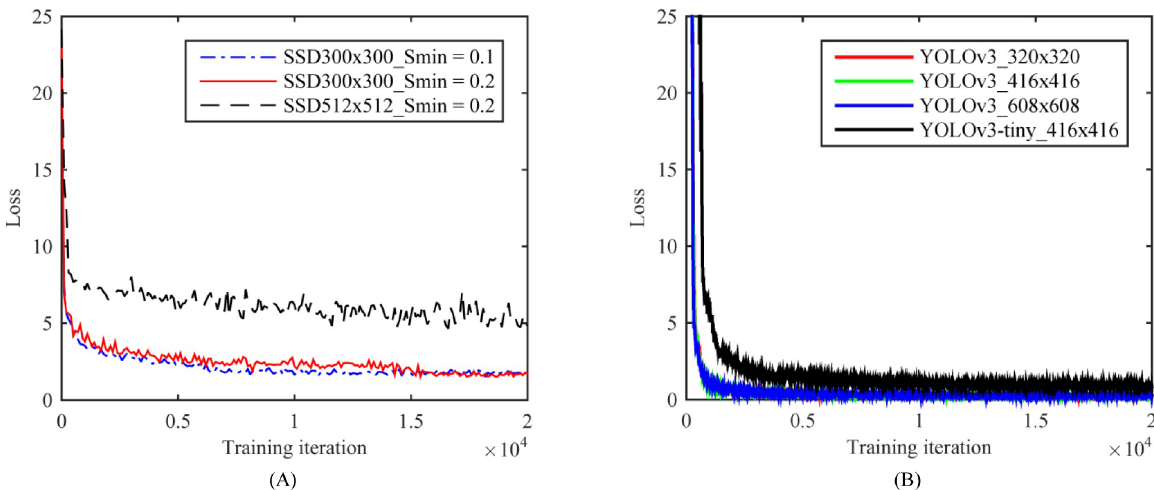
Fig 7. Convergence studies on train loss with respect to the number of iterations. (A) Effect of different scales of default boxes by changing hyper parameter Smin and input size on SSD model convergence; (B) Effect of different input size and backbone net on YOLOv3 model